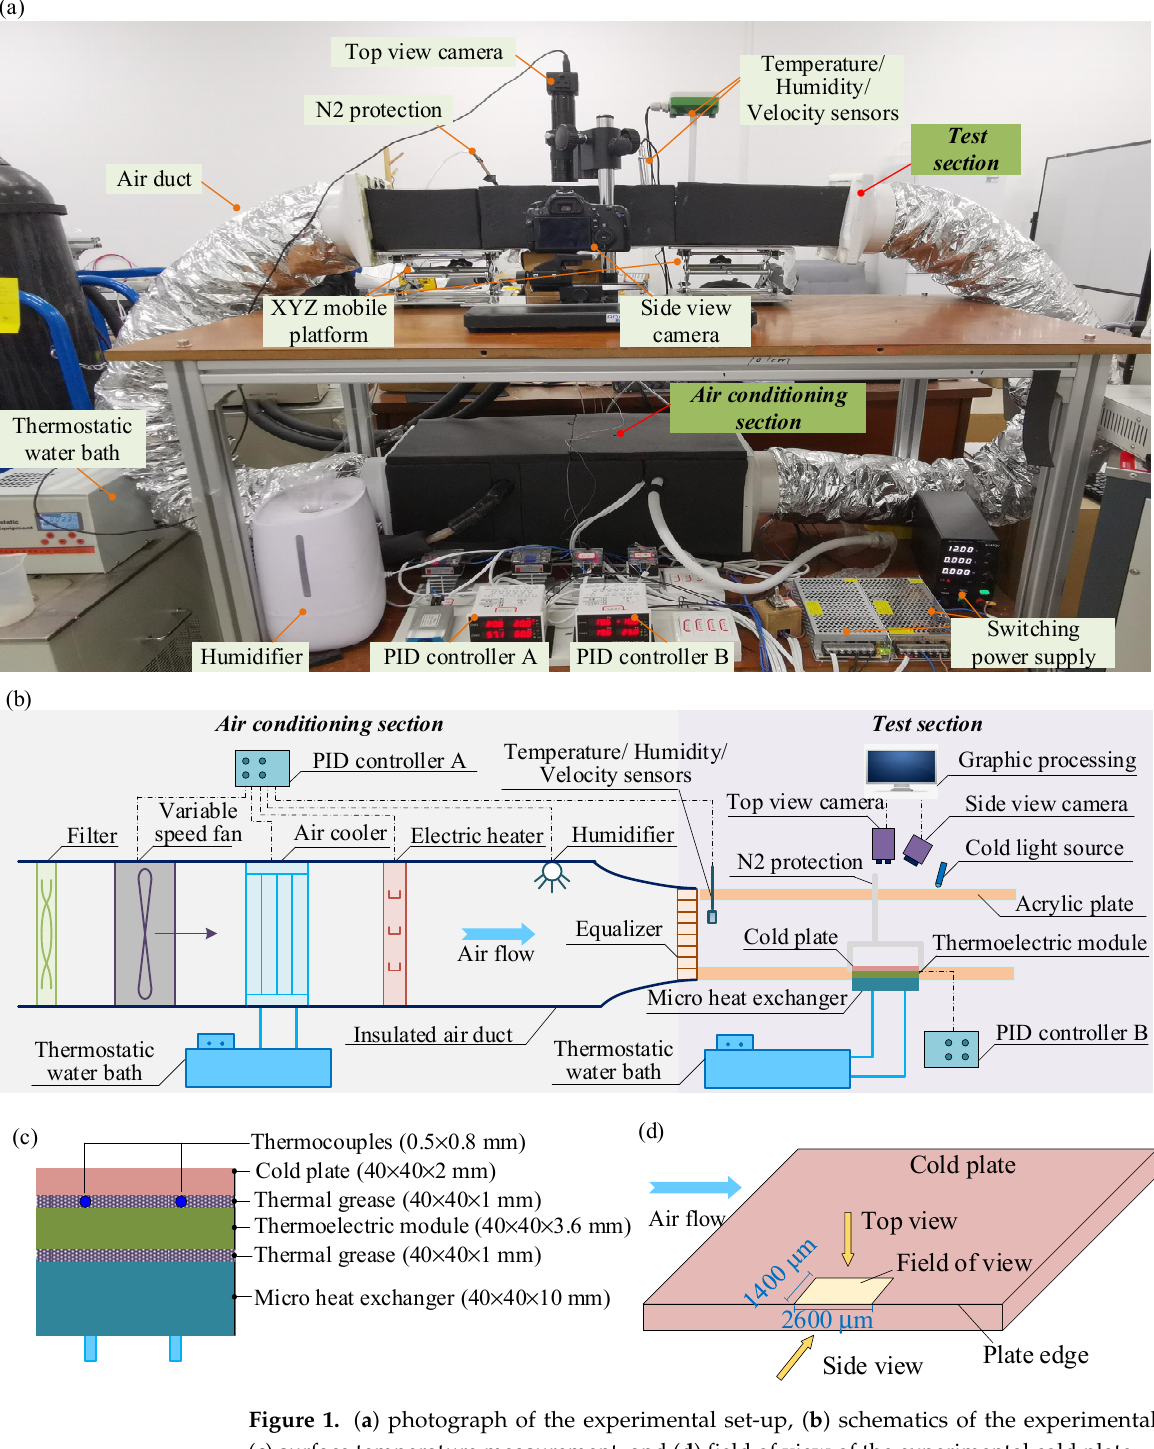
1080, respectively.